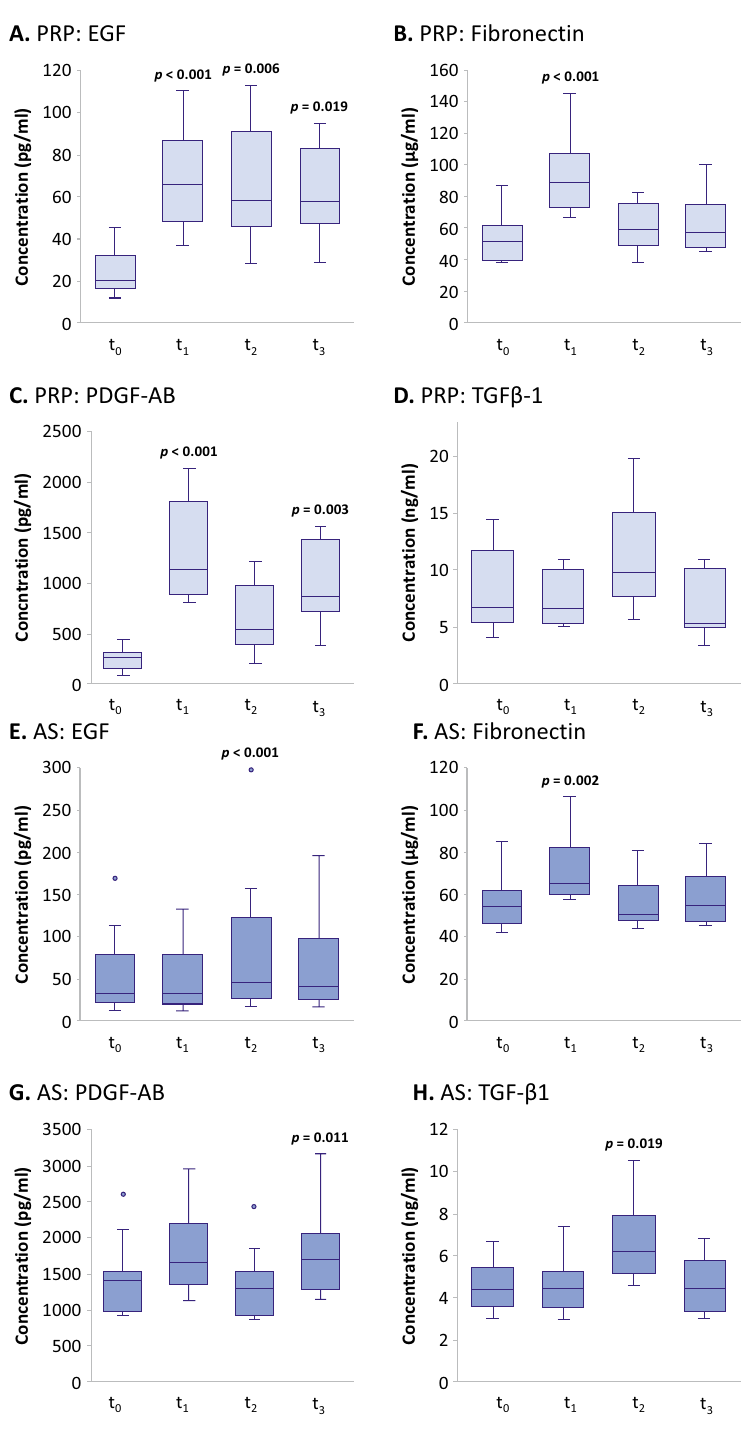
Figure 4. Concentrations of epitheliotrophic growth factors and fibronectin at baseline (t 0 ), after storage at 4 °C for 1 week (t 1 ), and after storage at − 20 °C for 1 month (t 2 ) and 3 months (t 3 ). Median and interquartile range of concentrations are shown in box plots (N = 10 for each group). The presence of p- value above data at any conditions signifies that the difference between concentrations at baseline (t 0 ) and those at that condition (t 1 , t 2 , or t 3 ) is statistically significant as analyzed by Dunn’s test. Conversely, the absence of p -value above data at any conditions signifies no statistically significant differences between those at baseline (t 0 ) and at that condition (t 1 , t 2 , or t 3 ). The factors shown here are: ( A,E ) EGF; ( B,F ) fibronectin; ( C,G ) PDGF-AB; and ( D,H ) TGF-β1; when ( A–D ) are concentrations in platelet-rich plasma (PRP) and ( E–H ) are those in autologous serum